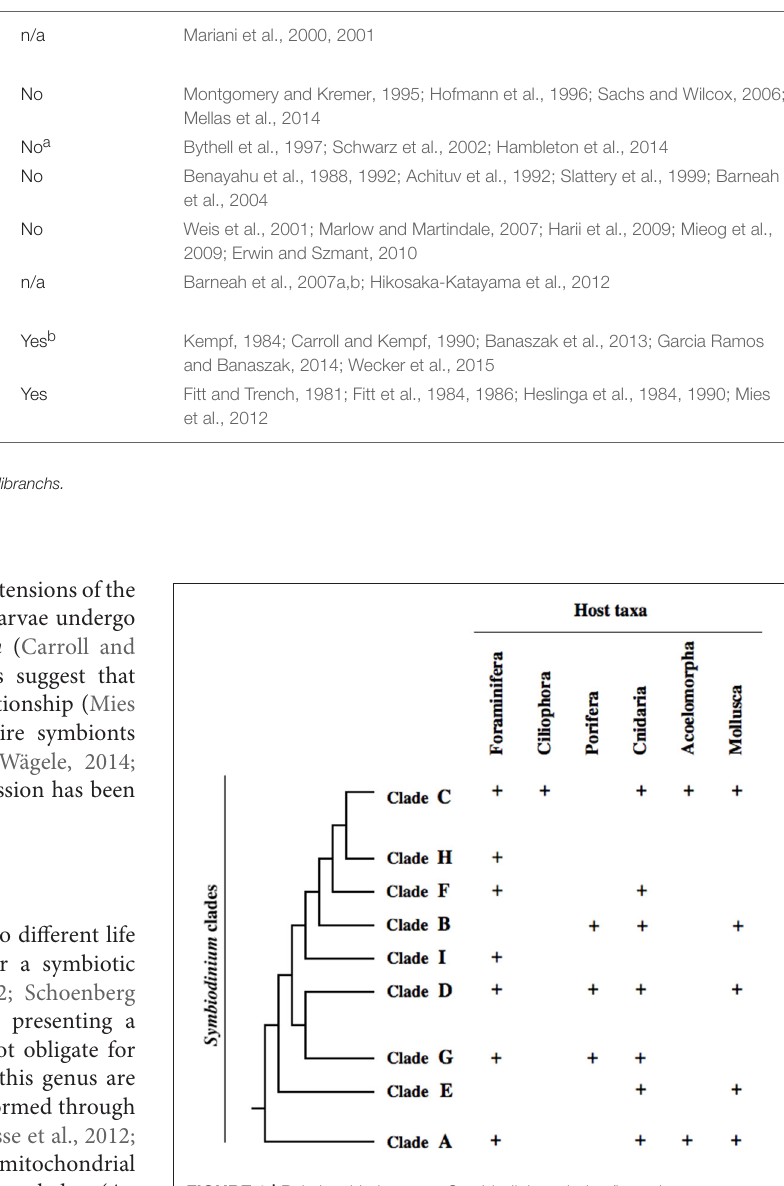
FIGURE 1 | Relationship between Symbiodinium clades (based on a multigene phylogeny–see Pochon et al., 2014) and their distribution in host taxa according to Stat et al. (2006); Barneah et al. (2007b), and Pochon et al. (2014).